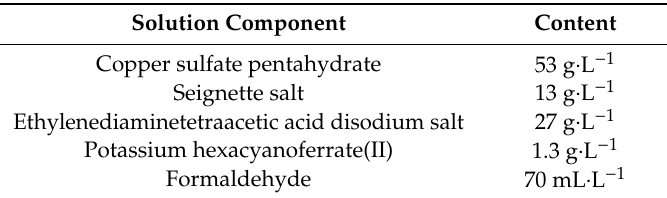
Table 1. Electroless Cu–Ni solution.